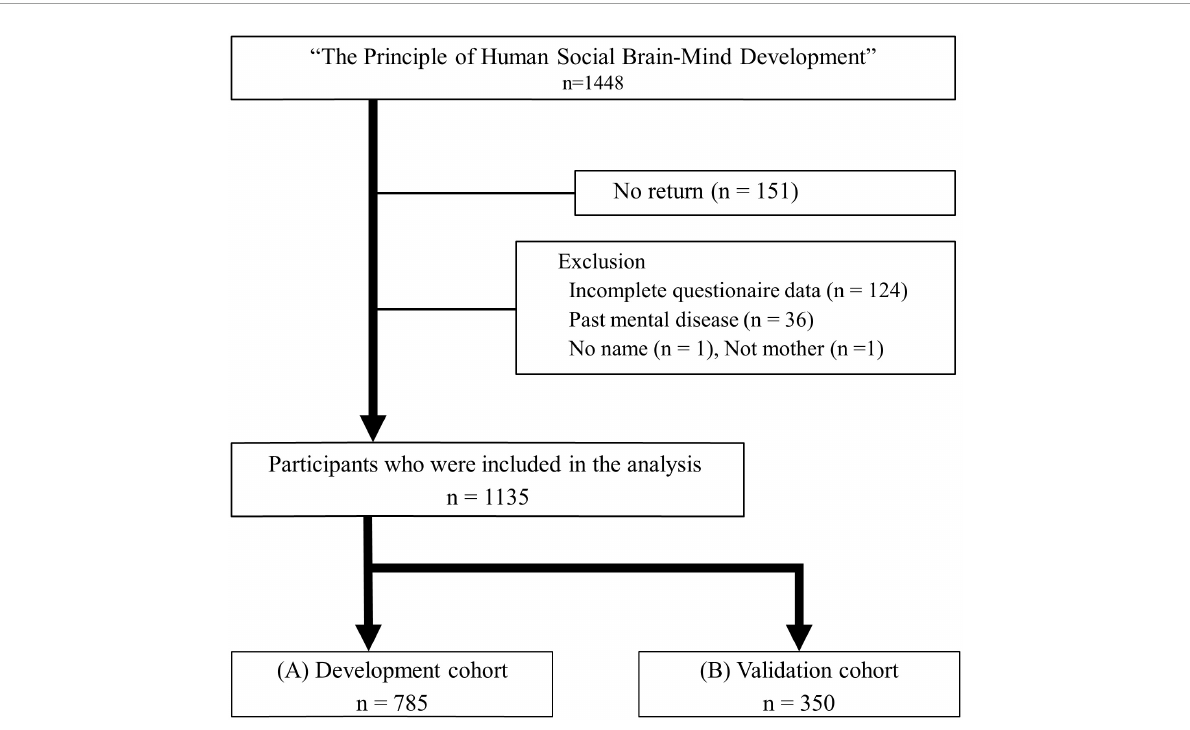
FIGURE1 Flowchart of patient enrolment for the development and validation cohorts. (A) Development cohort. (B) Validation cohort. MDPS, multidimensional physical score.